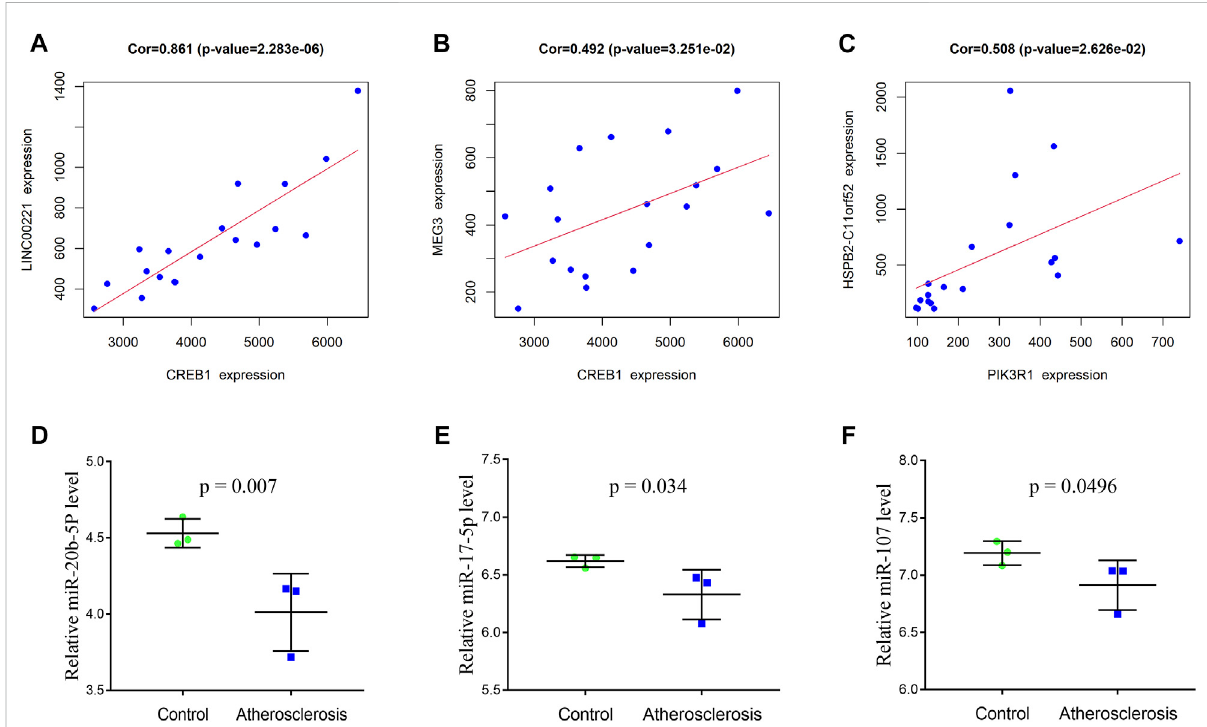
FIGURE 6 Correlation between the expression of immune-related core DE_mRNAs and their paired lncRNAs (A – C) . Validation of the miRNAs of the immune-related core ceRNA network in GSE137580 (D – F) . The results with statistically signi fi cant differences ( p < 0.05) are